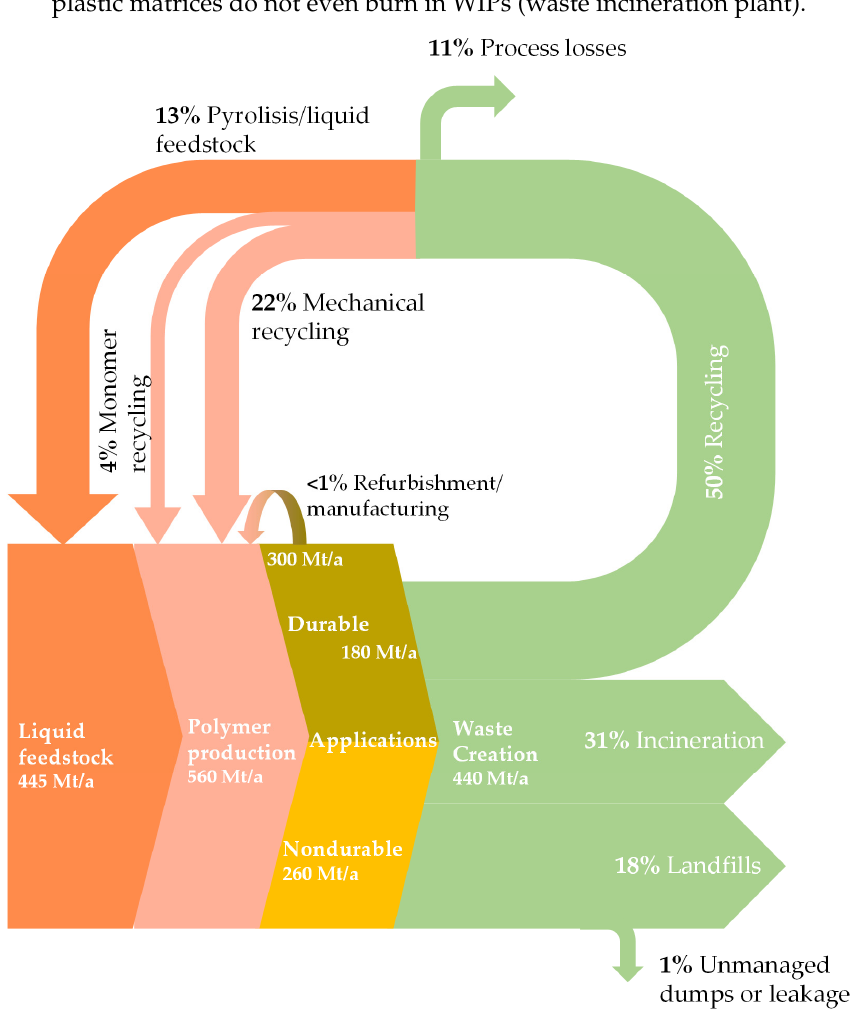
Figure 1. Global waste polymer flows 2030 at a recycling rate of 50%. Data from [66].